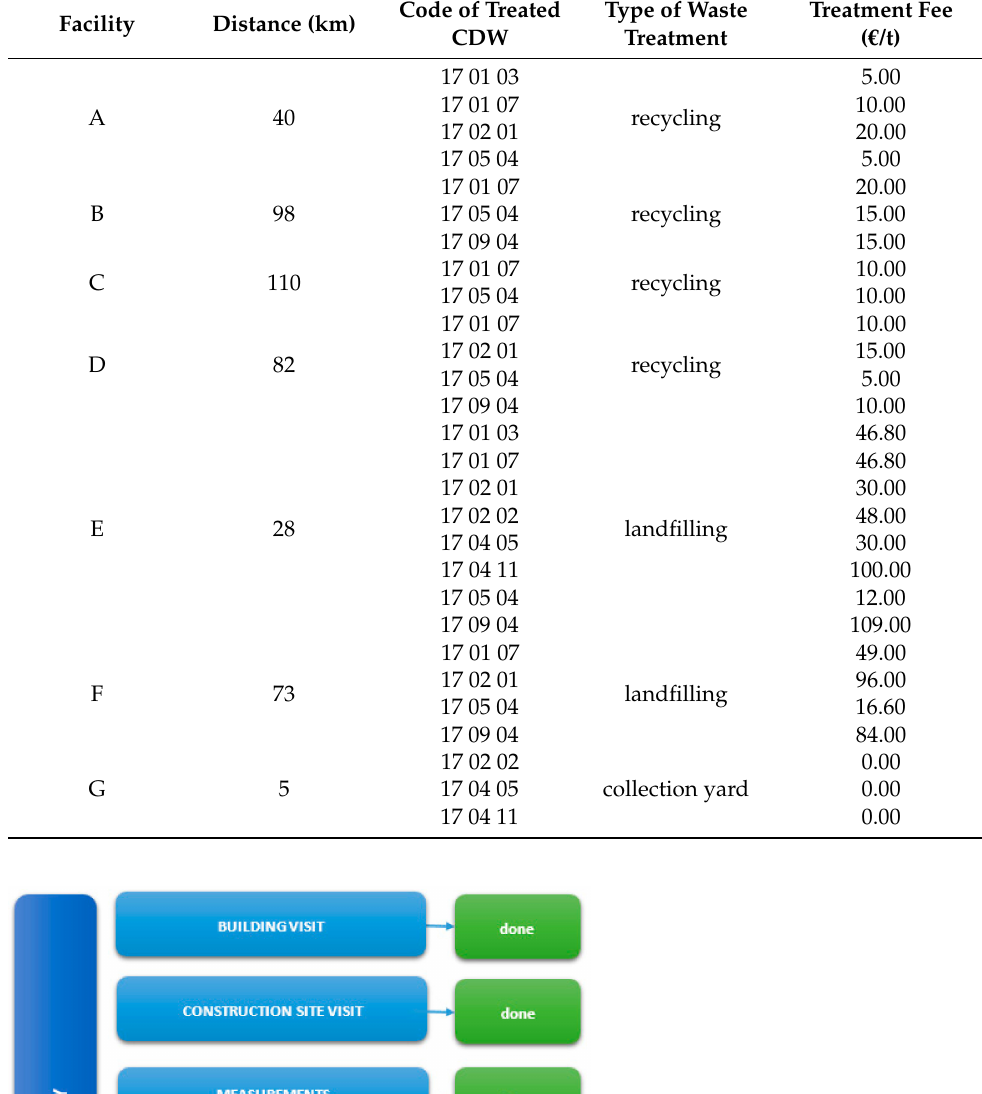
Table 7. Waste management facilities in the Snina region.